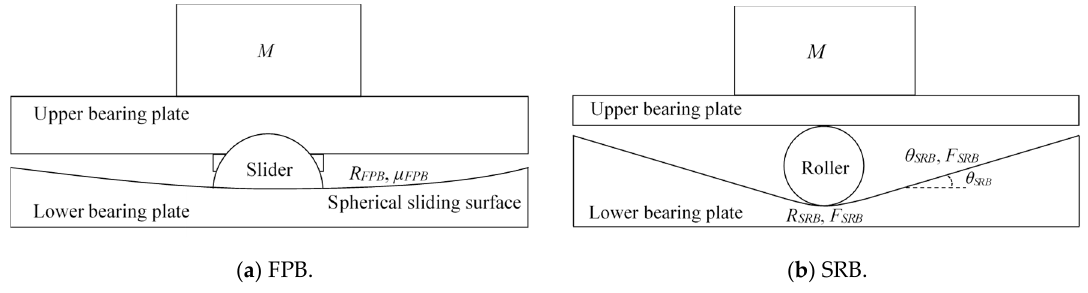
Figure 1. Simplified models for friction pendulum bearings (FPBs) and sloped rolling-type bearings (SRBs).